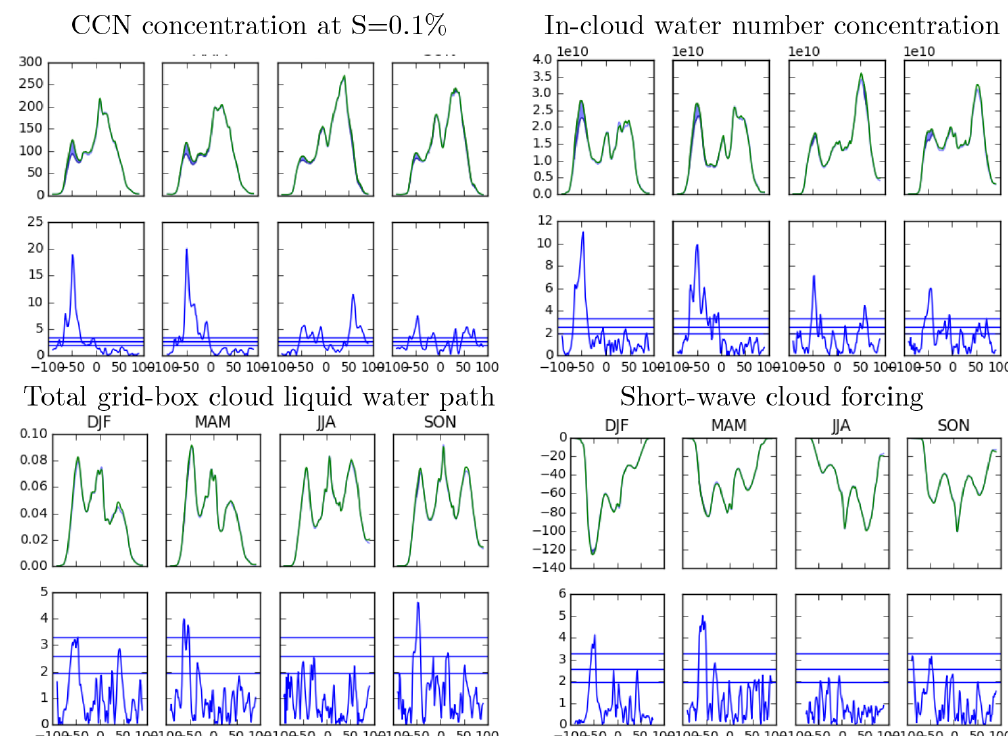
Figure 11. Zonal mean fields from the control (black) and INT_ADD sensitivity cases (green) for each season and Welch’s t test statistic. Shading in top panels highlights regions where differences are significant at the p < 0.1% level, and horizontal lines in the bottom panels indicate levels of significance at p < 0.1%, p < 1%, and p < 5%. Variables shown are CCN concentration at S = 0.1% (top left), in-cloud water number concentration (top right), total grid-box cloud LWP (bottom left), and short-wave cloud forcing (bottom